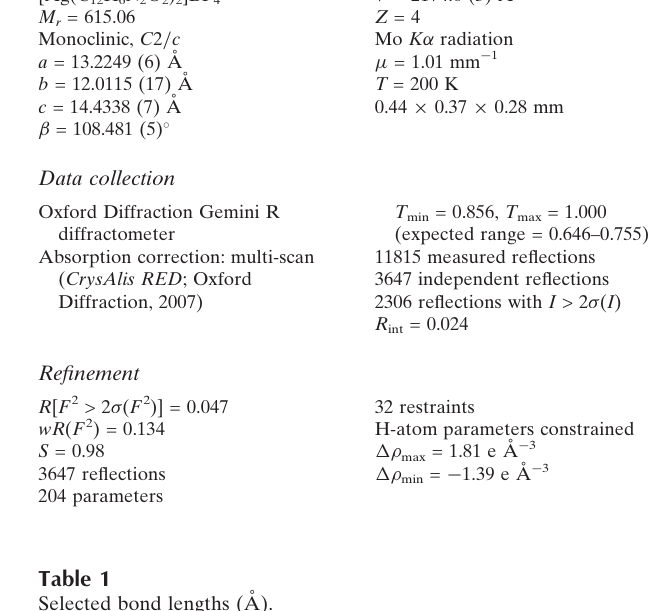
Selected bond lengths (A˚ ).